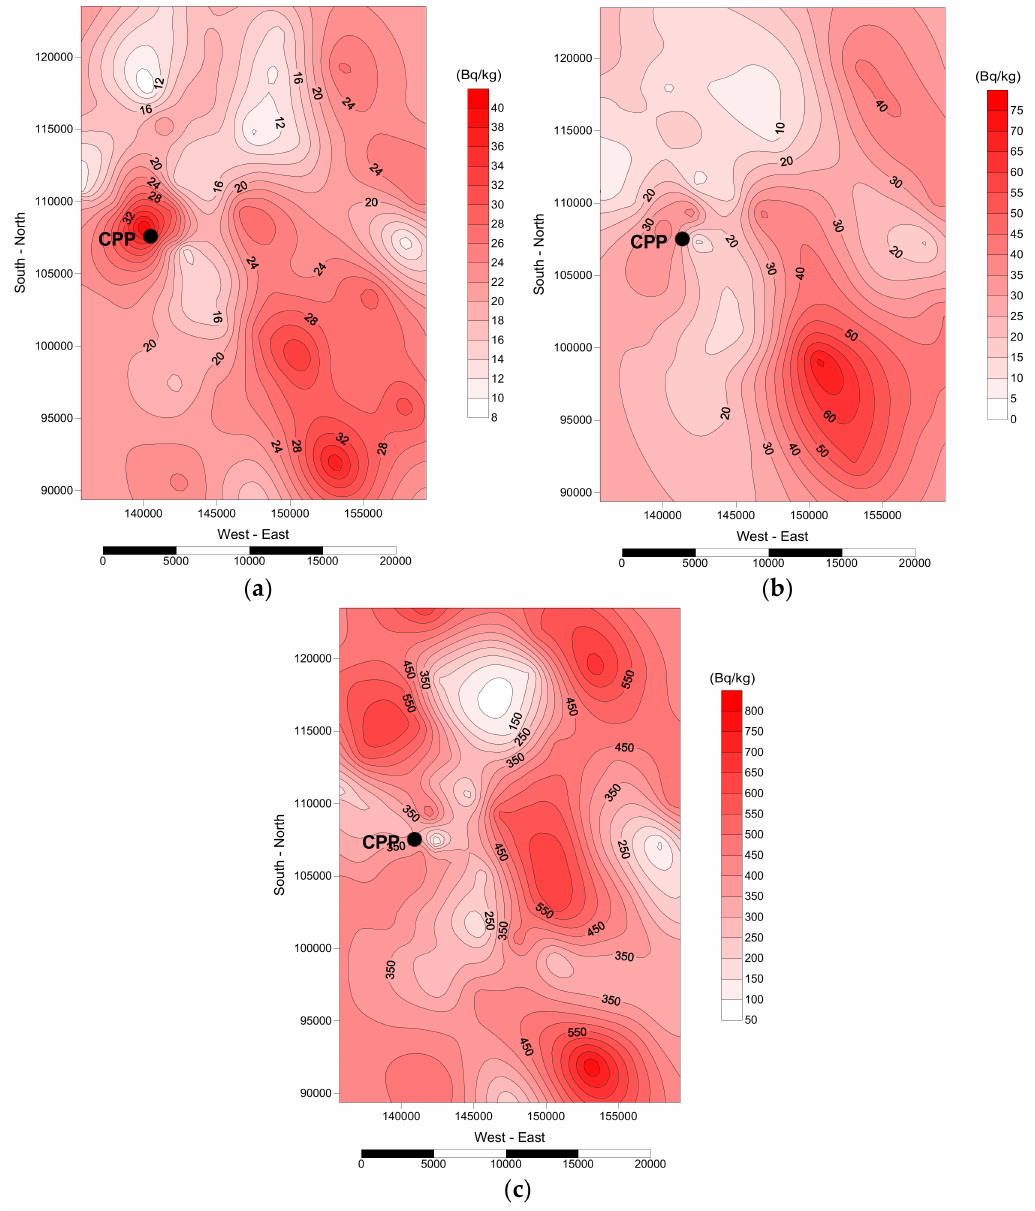
Figure 4. Spatial distribution of activity concentration, in Bq/kg: ( a ) 226 Ra, ( b ) 232 Th, and ( c ) 40